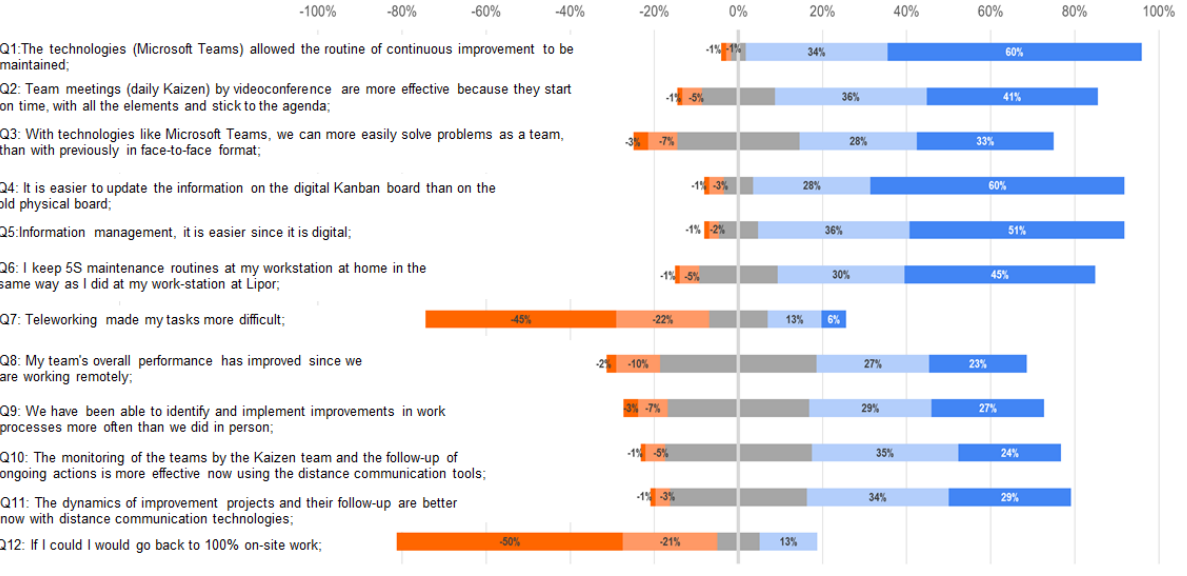
Figure 1. Percentage of “Agree” and “Strong agree” answers obtained from the questionnaires applied to production and office workers.